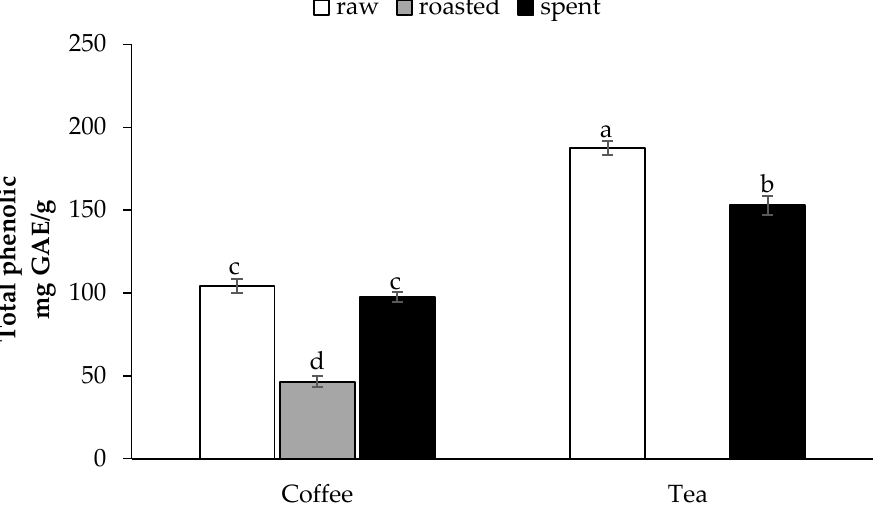
Figure 1. Phenolic content of spent coffee and black tea waste. Data represent the mean ± standard deviation (SD) ( n = 3). a–d Means with different letters are significantly different ( p ≤ 0.05) as assessed by least significant difference (LSD). GAE—gallic acid equivalent.